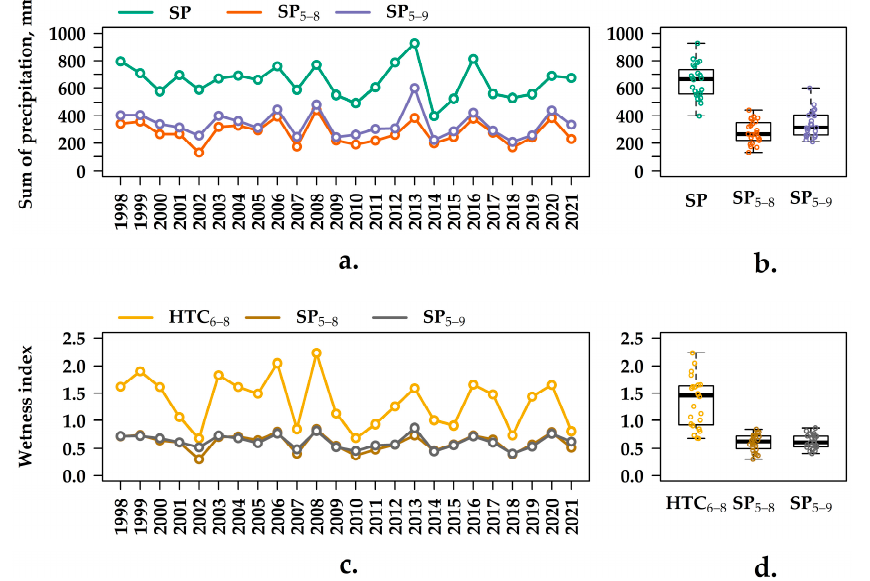
Figure 2. Dynamics of the meteorological indexes during the observation period ( a , c ) and their statistical characteristics ( b , d ): the median (bar), lower (Q1) and upper (Q3) quartiles (“boxes”); X1 = Q1 − 1.5 IQR (interquartile range, IQR = Q3 − Q1) and X2 = Q3 − 1.5 IQR (“moustaches”). All data are shown as dots. Meteorological indexes: SP is the annual sum of precipitation (mm); SP 5–8 and SP 5–9 are the sum of monthly precipitation from May to August and May to September, respectively; WI 5–8 and WI 5–9 are the wetness indexes from May to August and May to September, respectively; HTC 6–8 is the hydrothermal coefficient over the summer period